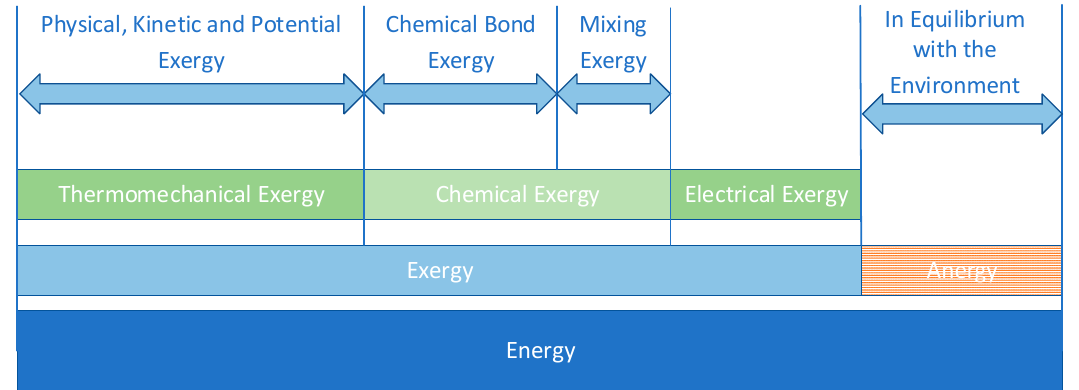
Figure 2. Energy divided into its fractions anergy and exergy. Anergy is in full thermodynamic equilibrium with the environment, while exergy forms thermomechanical exergy, chemical exergy, and electrical exergy. Nuclear exergy is neglected. Following [9].